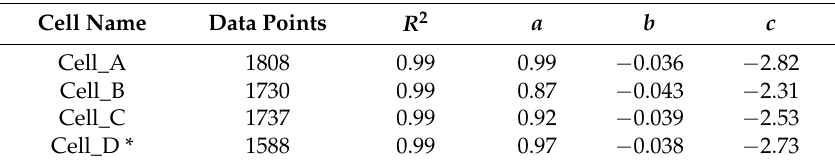
Table 3. SOC model coefficients using different cells as training data.